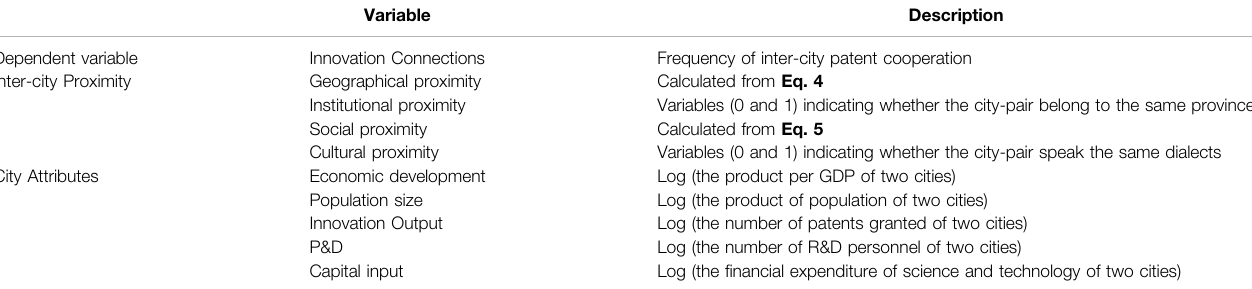
TABLE 2 | Main variables and measurement methods.